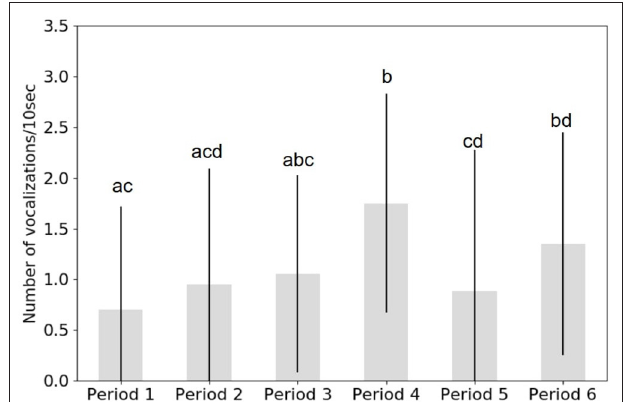
FIGURE 6 | Graph of the mean of the call rate for each period of the 11st of August for each period (1–6) and the SD. The letters (a,b,c,d) show statistically significant differences between periods. Letters in common between periods mean that they are not significantly different. The arrival of the boat is during period 3.